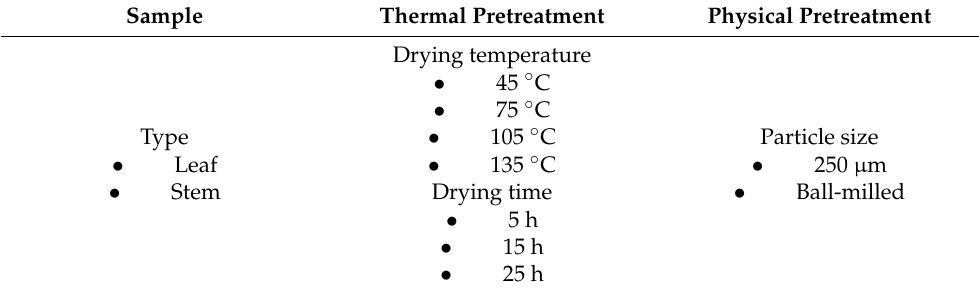
Table 1. Pretreatment parameters.